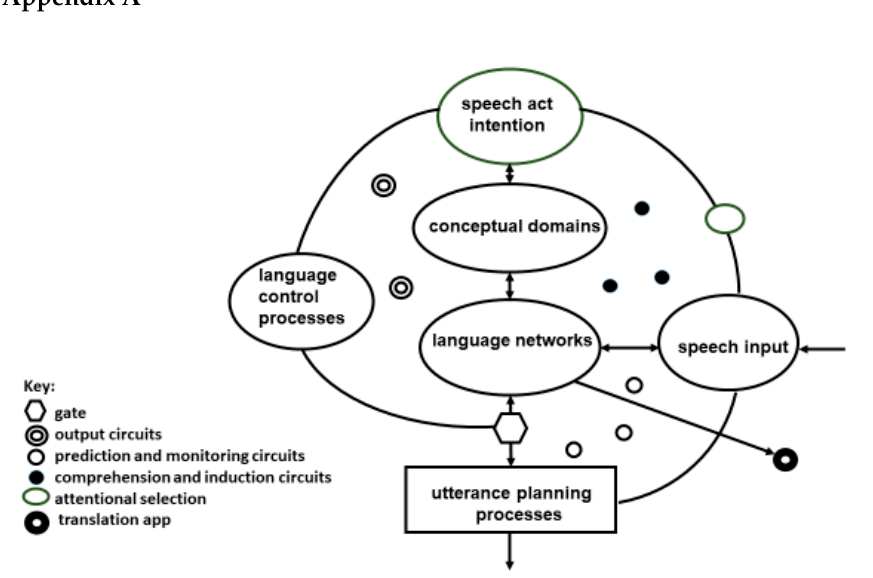
Figure A1. Mapping the speech act when a word or phrase is unknown in the target language (adapted from Green 2019).